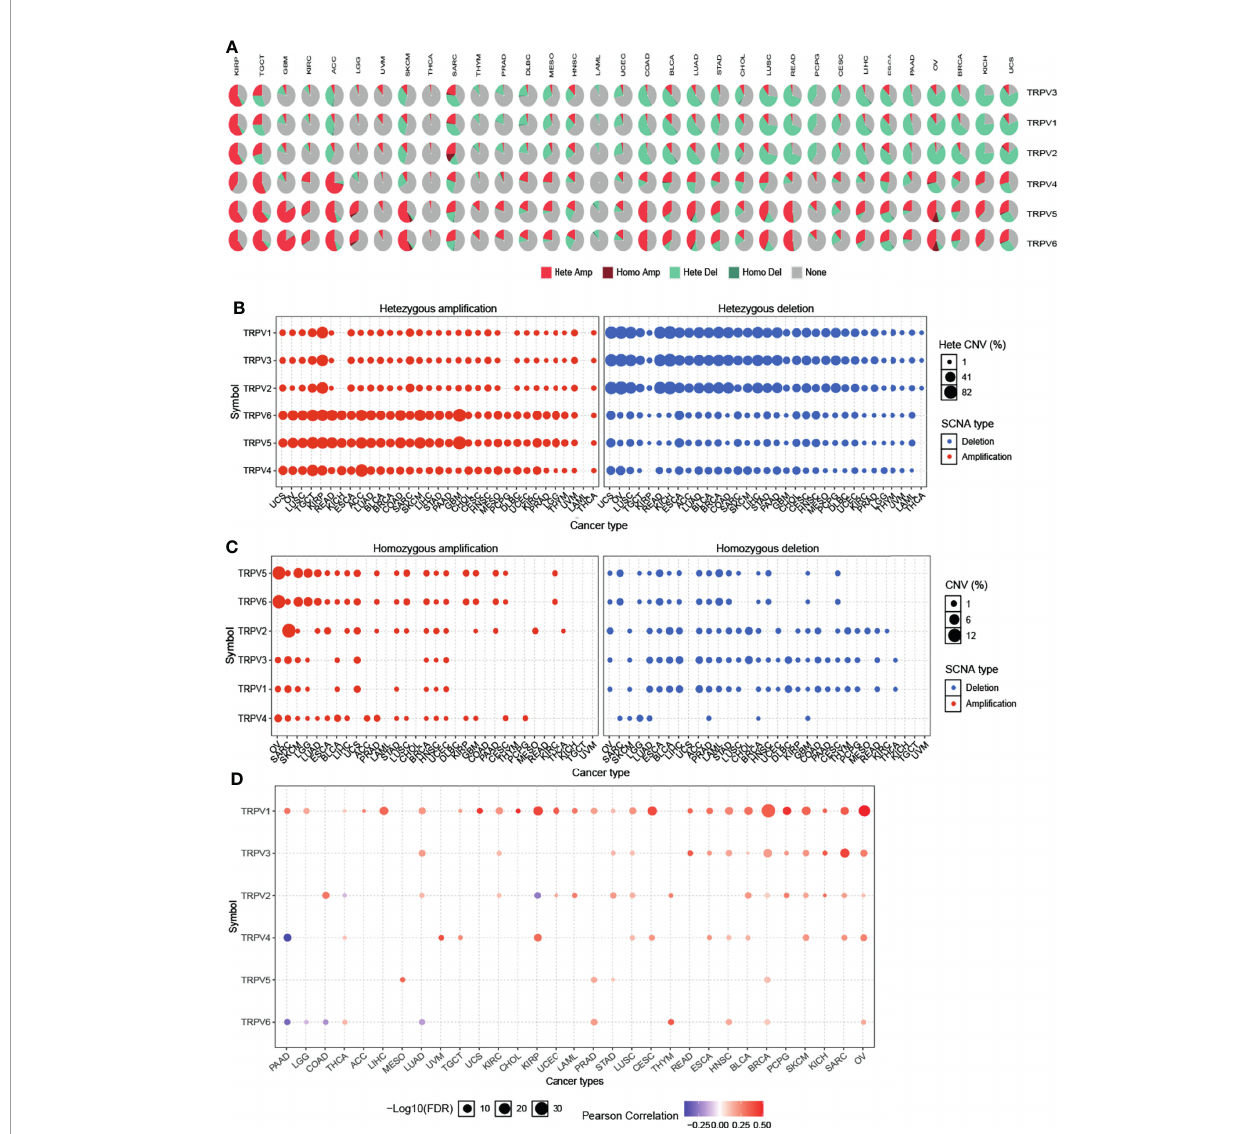
FIGURE 3 | Copy number variation of TRPV channel-related genes. (A) CNV pie chart of 33 cancers. The CNV pie chart shows the combined heterozygous/homozygous CNV ratio of each regulator in each cancer. A pie chart representing the proportion of different types of CNV for each TRPV gene per cancer subtype; different colors represented different types of CNV. (B) The heterozygous CNV pro fi le shows the percentage of heterozygous CNV, including the percentage of heterozygous ampli fi cation and deletion for each TRPV subtype gene in each cancer subtype. (C) The homozygous CNV pro fi le shows the percentage of homozygous CNV, including the percentage of homozygous ampli fi cation and deletion for each TRPV subtype gene in each cancer. Only a gene with >5% CNV in a given cancer appears as a dot on the graph. (D) CNV correlation with TRPV channel mRNA expression. The Pearson product-moment correlation coef fi cient was used to study the association between CNV and mRNA expression. All dots with signi fi cant differences are shown. The size of a dot represents statistical signi fi cance, and the larger the size of the dot, the higher the statistical signi fi